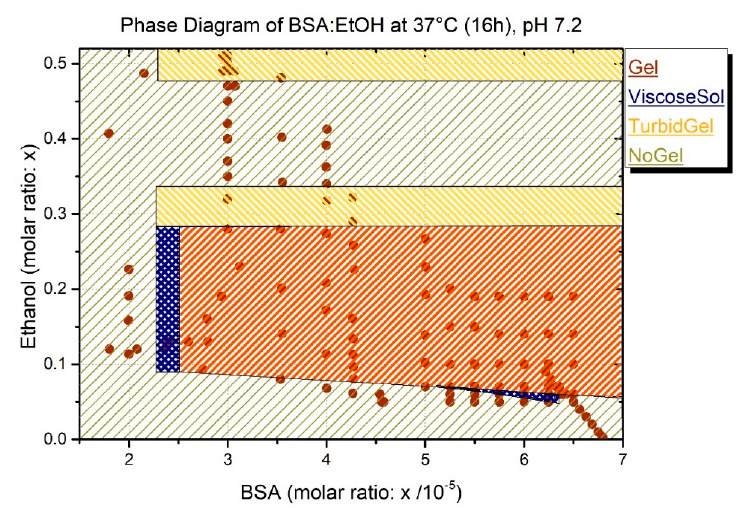
Figure 1. Phase diagram of bovine serum albumin (BSA) after 16 h at 37 °C (data points based on Table A1). ViscosSol refers to viscous solution but fall short of being a robust gel. Gel refers to clear